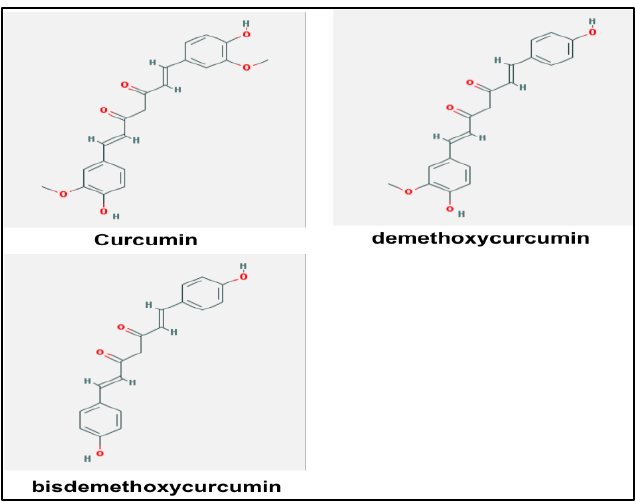
Figure 3. Curcuminoids of Curcuma longa . Chemical structures were taken from the PubChem Substance and Compound database (pubchem.ncbi.nlm.nih.gov). The